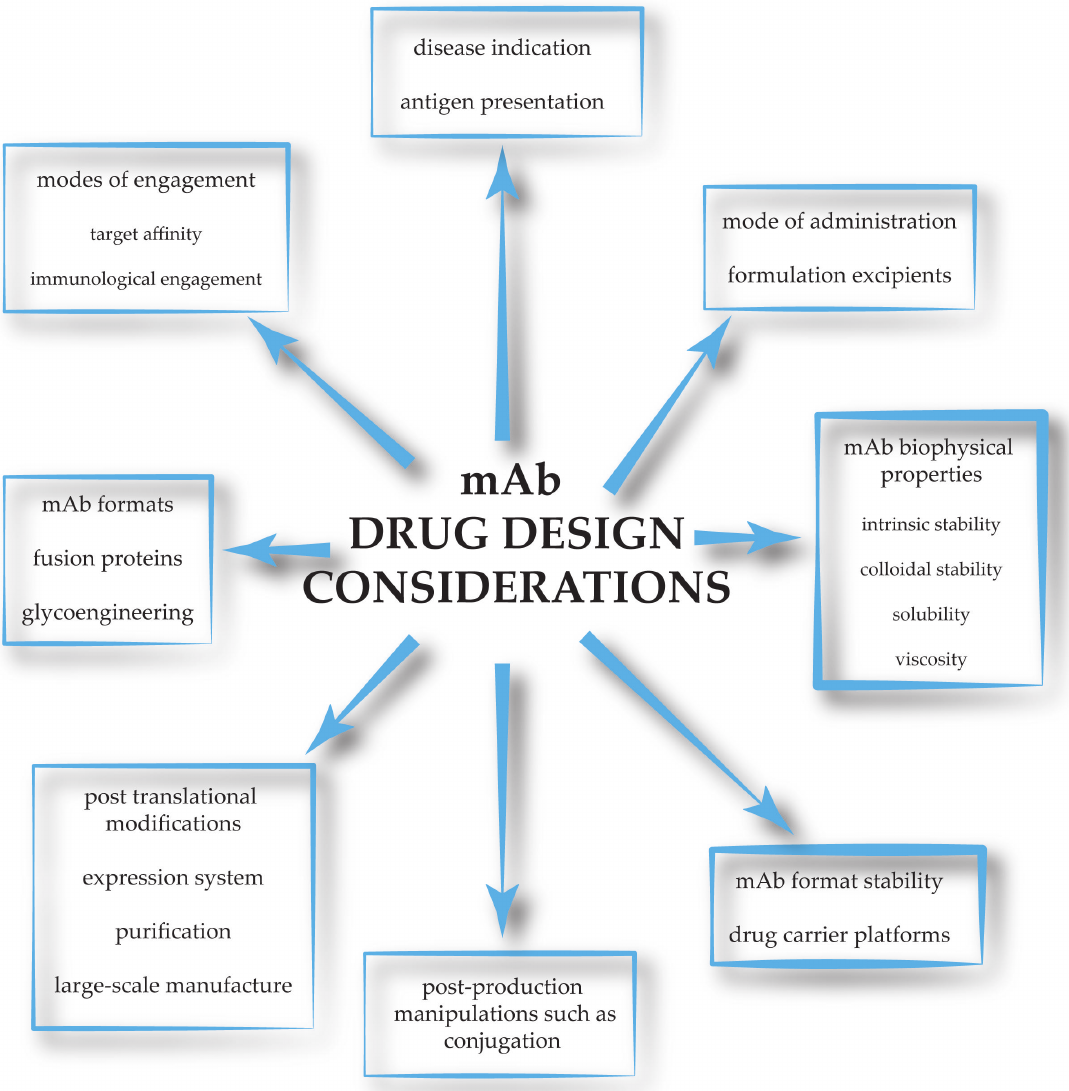
Figure 3. Schematic representation of the concept stages of mAb drug development in which considerations follow on from one process to the next in the design and manufacture of mAb-based